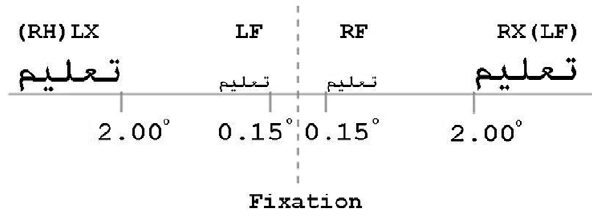
Figure 1. Screen locations of foveal and extrafoveal stimuli in Experiments 1 and 2. Footnote: The size of foveal and extrafoveal stimuli was matched for visibility. The terms RH and LH refer to the hemisphere contralateral to the hemifield in which stimuli were presented.